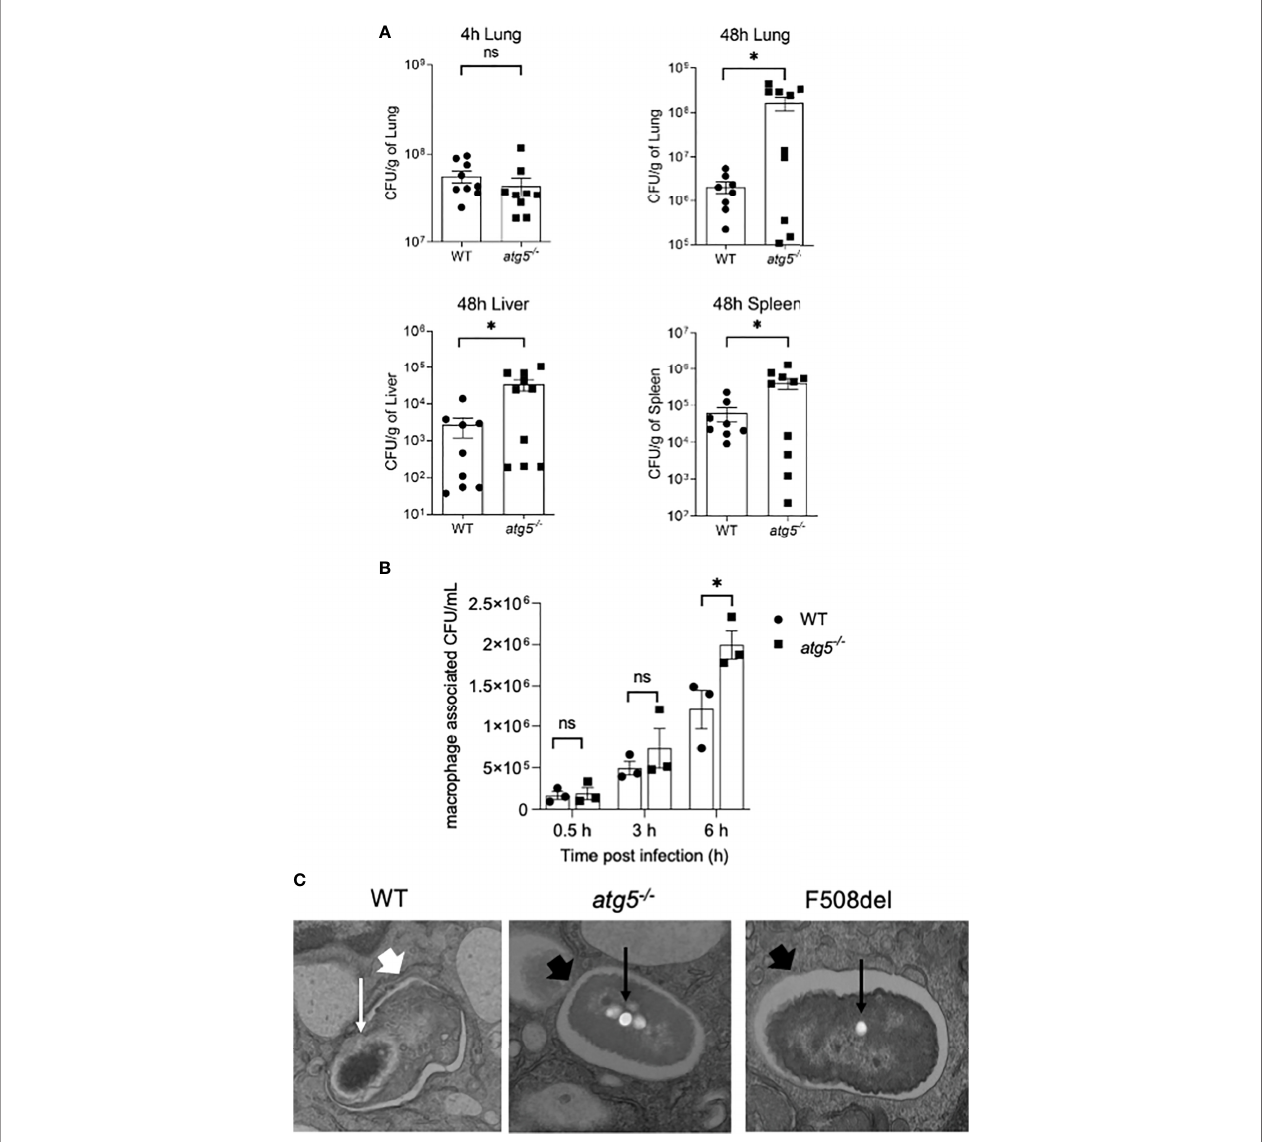
FIGURE 5 | Autophagy activity in macrophages is essential for restricting Burkholderia cenocepacia in vivo and in vitro . (A) Colony-forming units (CFUs) in lung, liver, and spleen from wild-type (WT) and atg5 − / − mice intratracheally infected with B. c. at indicated time points. Data represent mean ± SEM (n = 5 biological replicates). Statistical analysis was performed using a two-tailed Student ’ s t-test; *, p ≤ 0.05; ns, non-signi fi cant. (B) Intracellular survival of B. cenocepacia in WT and atg5 − / − macrophages at 0.5, 3, and 6 h. Data represent mean ± SEM (n = 3 biological replicates). Statistical analysis was performed using two-way ANOVA; *, p ≤ 0.05; ns, non-signi fi cant. (C) Qualitative transmission electron microscopy images of B. c . infected WT, atg5 − / − , and F508del macrophages at 2 h post-infection. White arrows indicate a multilamellar membrane characteristic for autophagosomes, and the small arrows indicate the degraded bacteria. Black arrow indicates a single- membrane vacuole with intact bacteria indicated by small black